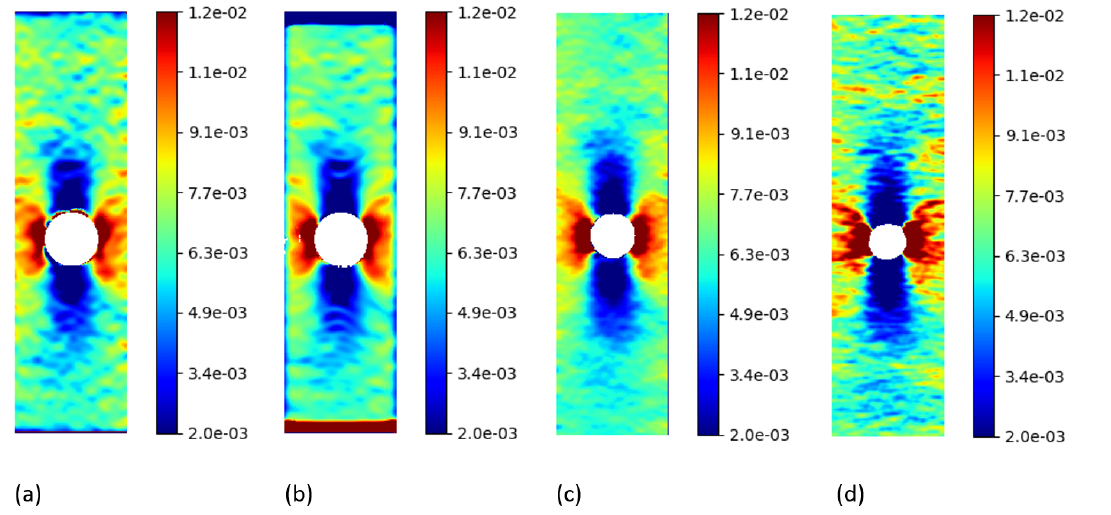
Figure 9. E yy Green Lagrangian strains for the “plate hole” sample from SEM DIC challenge obtained from DIC technique. ( a ) py2DIC results using Gaussian filter ( b ) py2DIC results using spline filter ( c ) Ncorr results ( d ) DICe